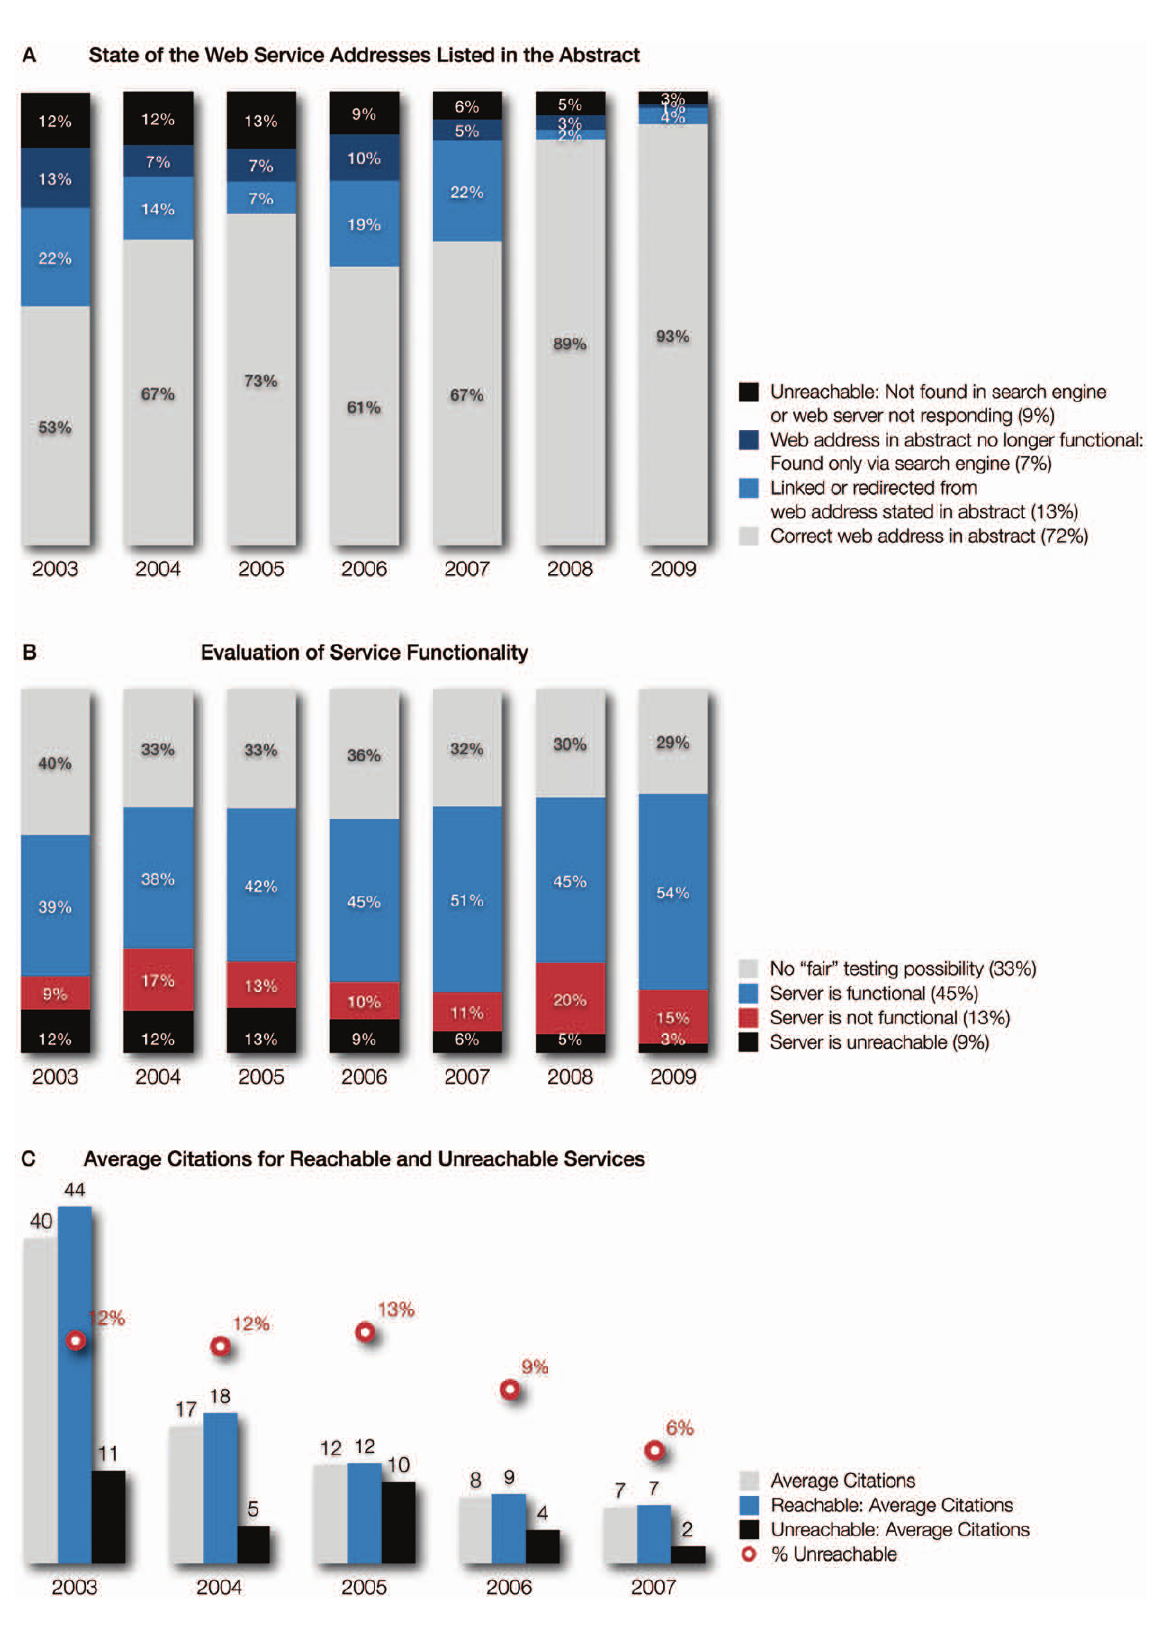
Figure 3. Changes in services’ Web address, functionality, and citations plotted by publication year. ( A ) The state of all Web service addresses listed in the abstracts. We extracted the services’ Web addresses from the NAR Web Server Issue abstracts and entered them into a Web browser to check for inconsistencies. We noted that, for many pages, the original published address is no longer current. The browser is either redirected transparently or a static link on the page informs the visitor of the address change (light blue). While this is a well-meant gesture,